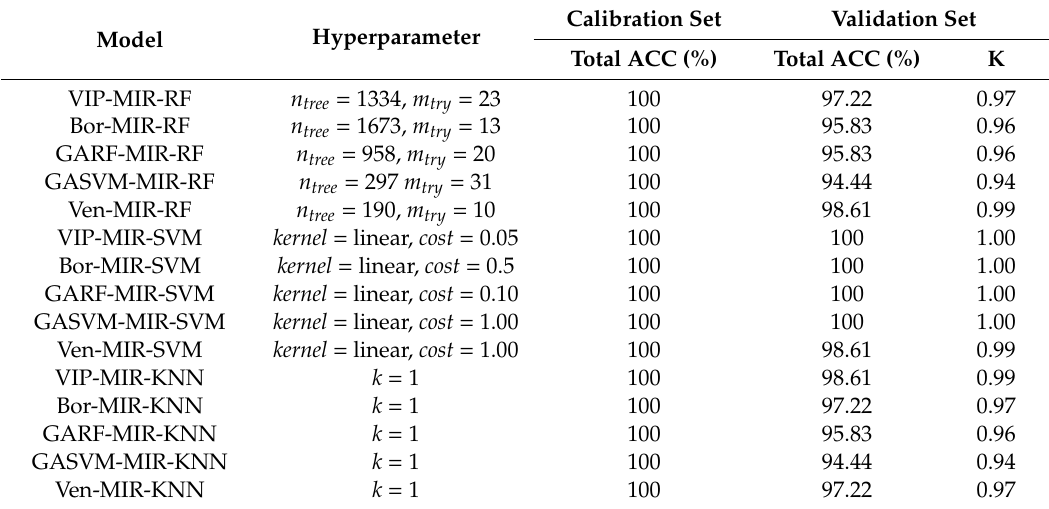
Table 8. The major parameters (accuracy and kappa) of classification models based on di ff erent FT-MIR feature